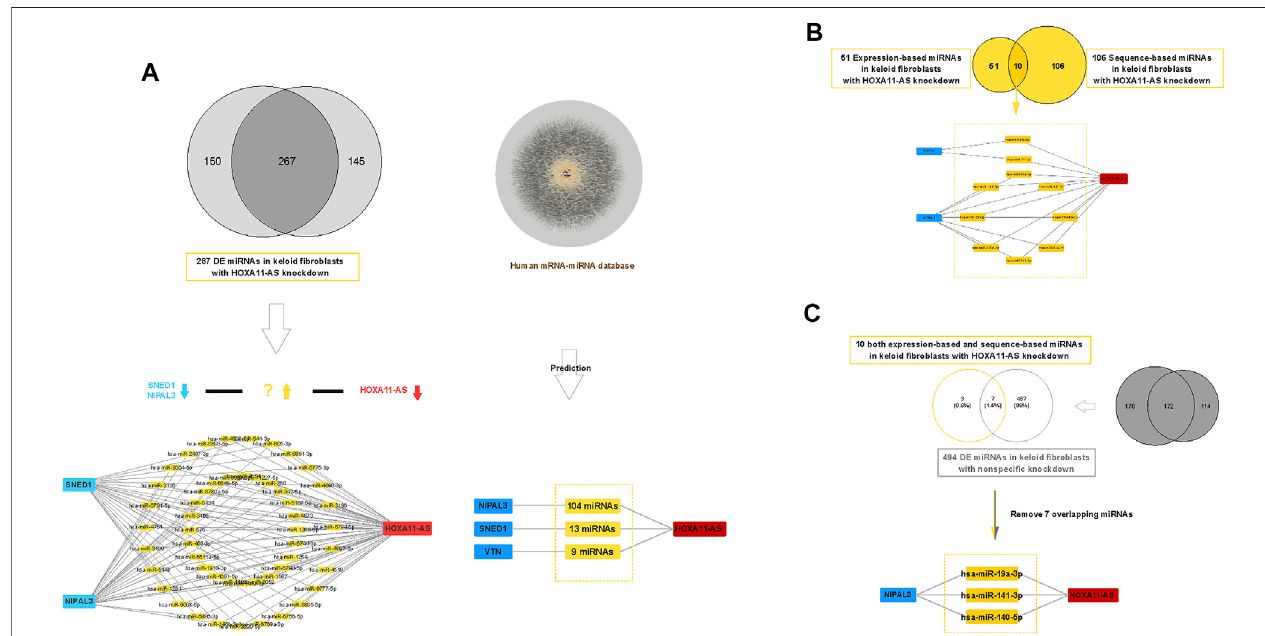
FIGURE 5 | Construction of a competing endogenous RNA (ceRNA) network of HOXA11-AS in keloid fi broblasts. Expression-based down regulated (HOXA11- ASknockdown) – up regulated (DE miRNAs) – down regulated (SNED1 and NIPAL3) ceRNA network constructed in keloid fi broblasts showing 51 upregulated miRNAs ( (A) , left). Expression-based Sequence-based prediction screened 106 unique competing endogenous miRNAs against HOXA11-AS based on two human predictive databases (lncRNA – miRNA and miRNA – mRNA) ( (A) , right). Based on dual prediction, there were 10 screened candidates sponging miRNAs in the HOXA11- AS – NIPAL3regulatorypathway (B) .AfterremovingsevenoverlappingmiRNAsthatwereshown among494nonspeci fi cmiRNAs,three upregulated miRNAs (hsa-miR- 19a-3p, hsa-miR-141-3p, and hsa-miR-140-5p) were identi fi ed as outcome sponging miRNAs inthe HOXA11-AS – NIPAL3regulatorypathway in keloid fi broblasts (C)